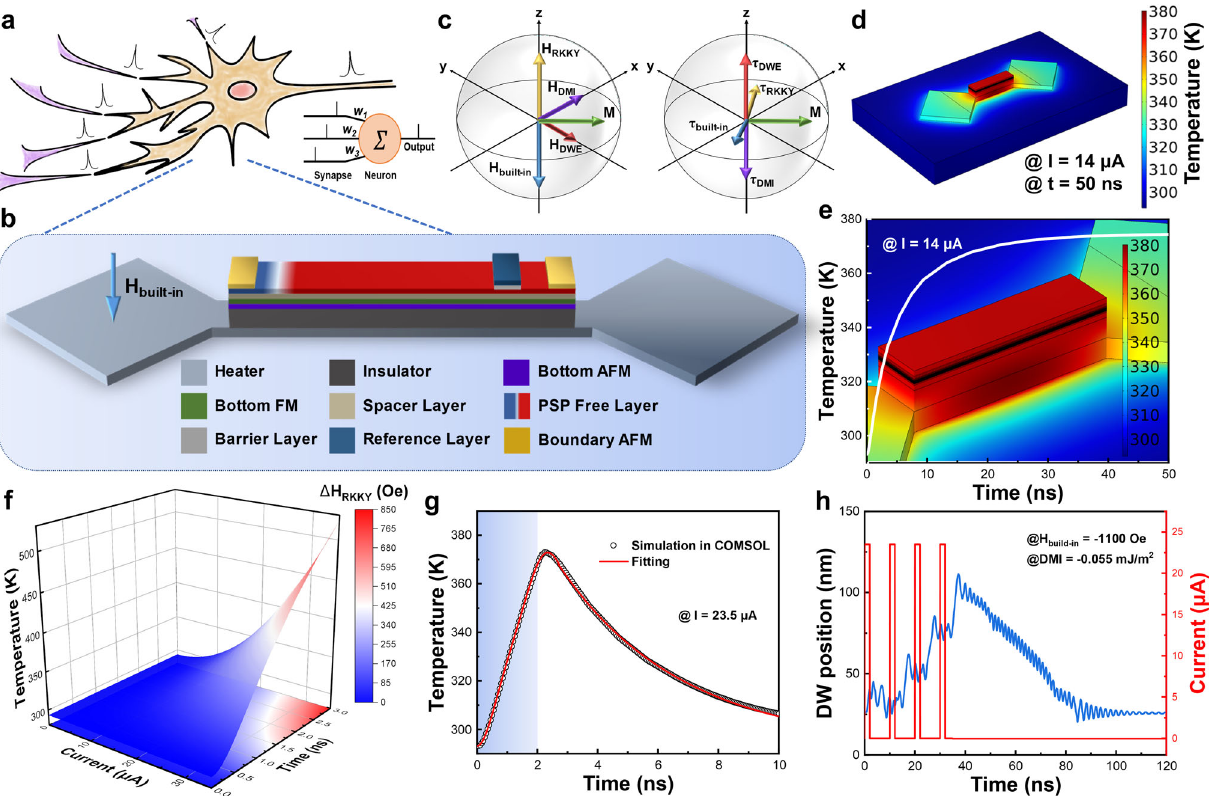
Fig. 4 | Joule heating temperature and DWM characteristics in the proposed device. Schematic of a biological neuron a and proposed spintronic neuron b . c Schematicdirectionsofeffective fi eldsandtorquesofupperferromagneticlayer. MdenotesthemagnetizationinDWcenter,thelongitudinaltorque τ DMI ,exchange torque τ RKKY ,DWenergytorque τ DWE andbuilt-intorque τ built-in isderivedfromthe